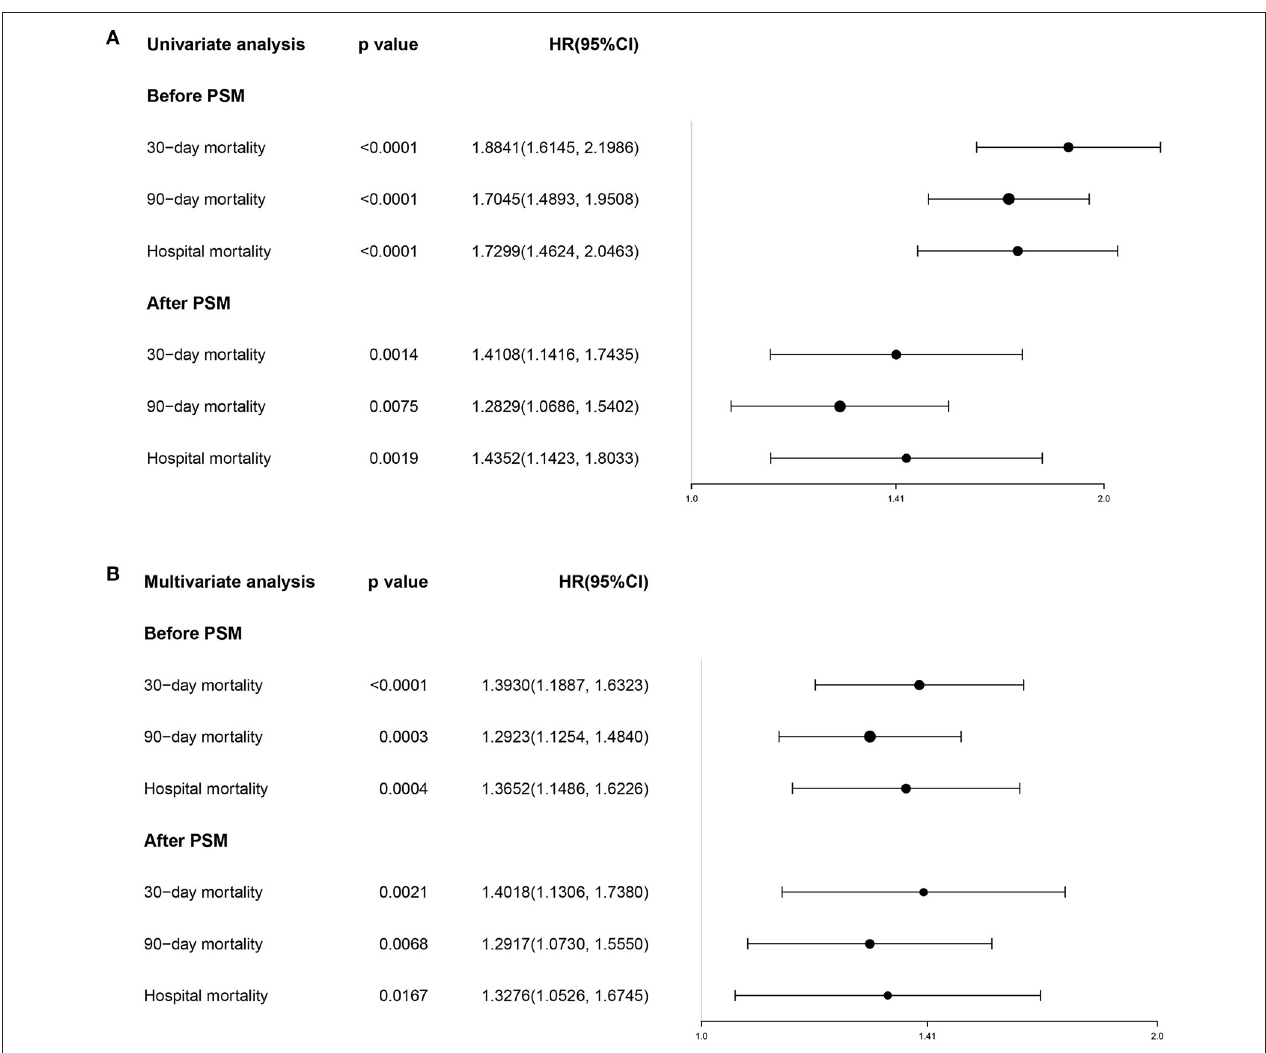
FIGURE 6 | The forest plot showing the univariate (A) and multivariate (B) Cox regression for effects of SII on short-term mortality in the critically ill patients with CHF before and after PSM. SII, systemic immune-inflammation index. CHF, congestive heart failure. PSM, propensity score